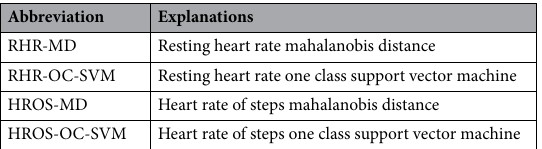
Table 1. Abbreviations.